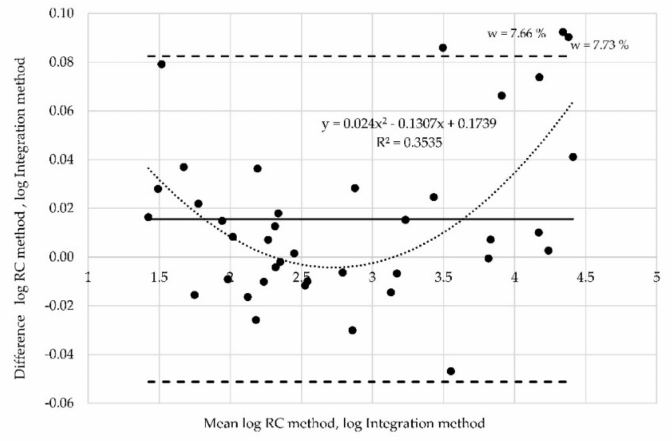
Figure 15. Altman plot for all samples measured at probe “A”—logarithmic transformation.